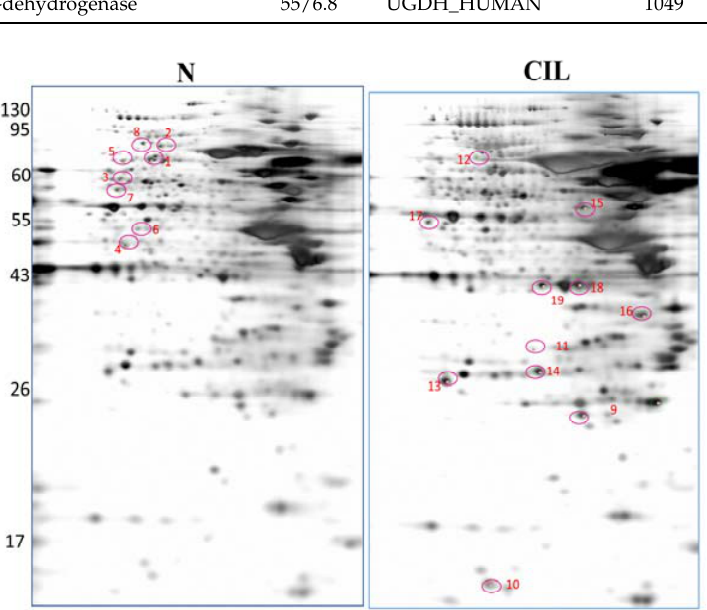
Figure 4. The representative two-dimensional gel electrophoretograms of DLD-1 cells, with or without the CIL-102 treatment. Six pairs of cell protein extracts from the CIL-102-treated and untreated DLD-1 cells were evaluated, and a representative pair of the proteomic gel images are shown. Nineteen protein spots (the upregulation of eight protein spots and the downregulation of 11 protein spots in the CIL-102-treated group) with a three-fold difference between both groups, were subjected to a MALDI-TOF-TOF analysis. The full names of these differentially displayed protein spots are encircled and annotated in Table 1, respectively.